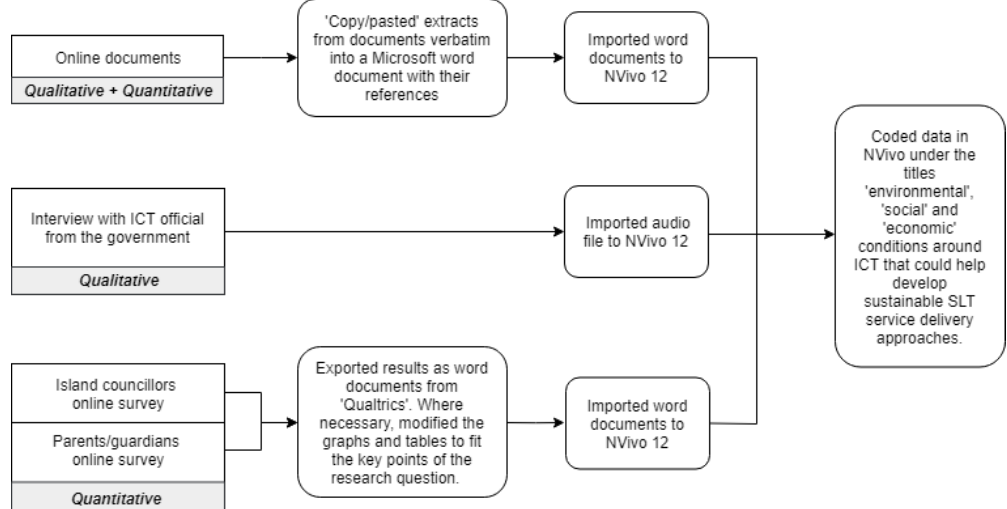
Figure 2. Mixed method data collection and analysis